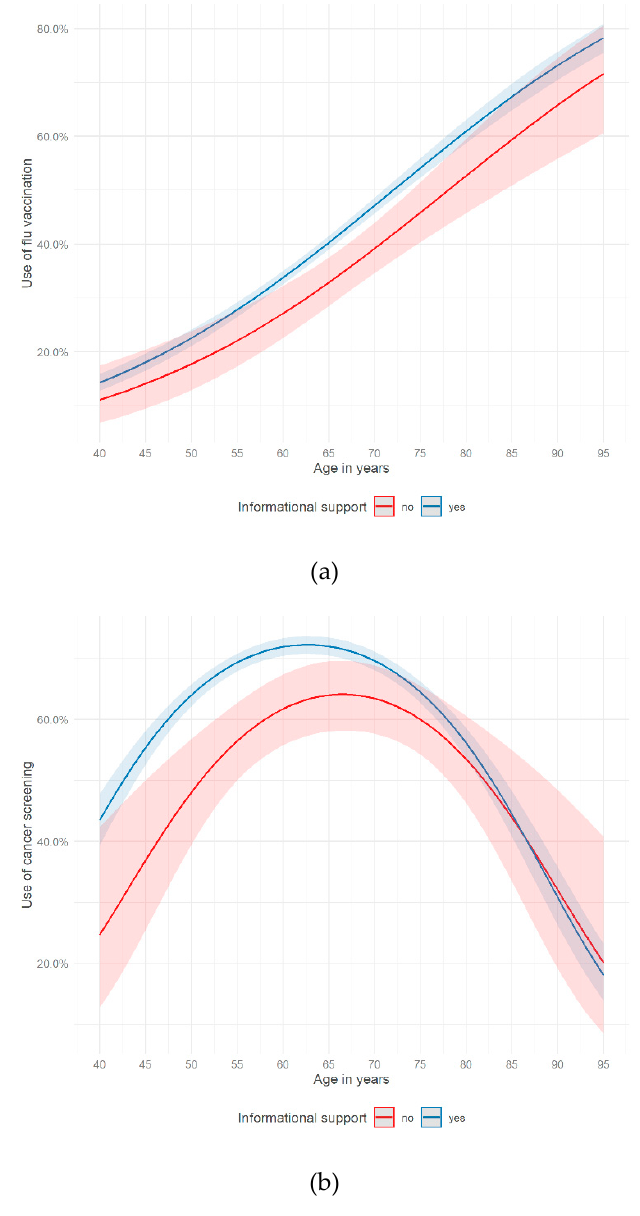
Figure 1. Use of ( a ) flu vaccination (Model 1.1) and ( b ) cancer screening (Model 2.1) on age and informational support (German Ageing Survey, 2014).